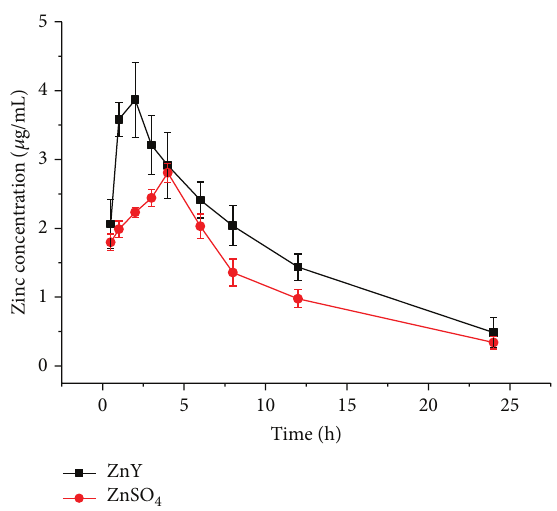
Figure 1: The mean plasma concentration-time profiles of ZnY and ZnSO 4 afterasingleoraladministrationofzinccompoundsatadose level of 4mg Zn/kg ( 𝑛 = 3